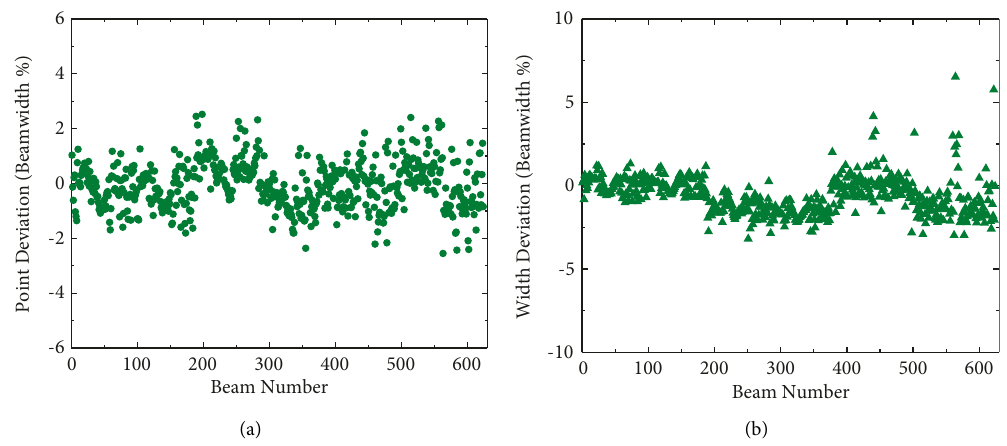
Figure 10: Beam deviation statistics. (a) Beam point deviation. (b) Beamwidth